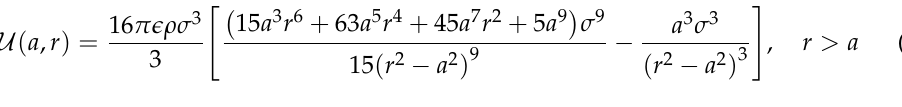
Figure 1. Illustration of the adsorbent with radius a . The distance between a volume element of the adsorbent and a gas molecule is given by r LJ , and the distance between the adsorbent center and the same gas molecule is given by r .